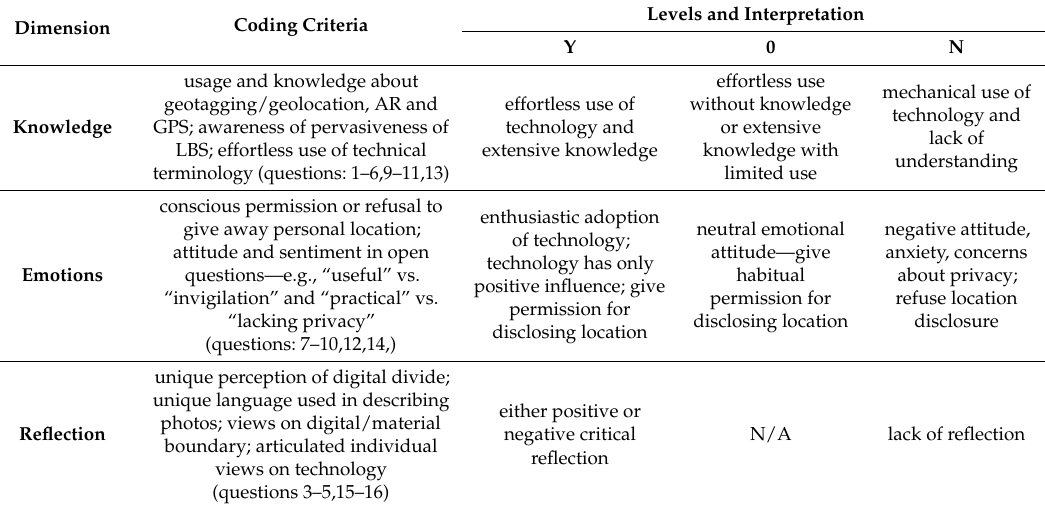
Table 1. Detailed coding criteria in three dimensions adopted in the study.